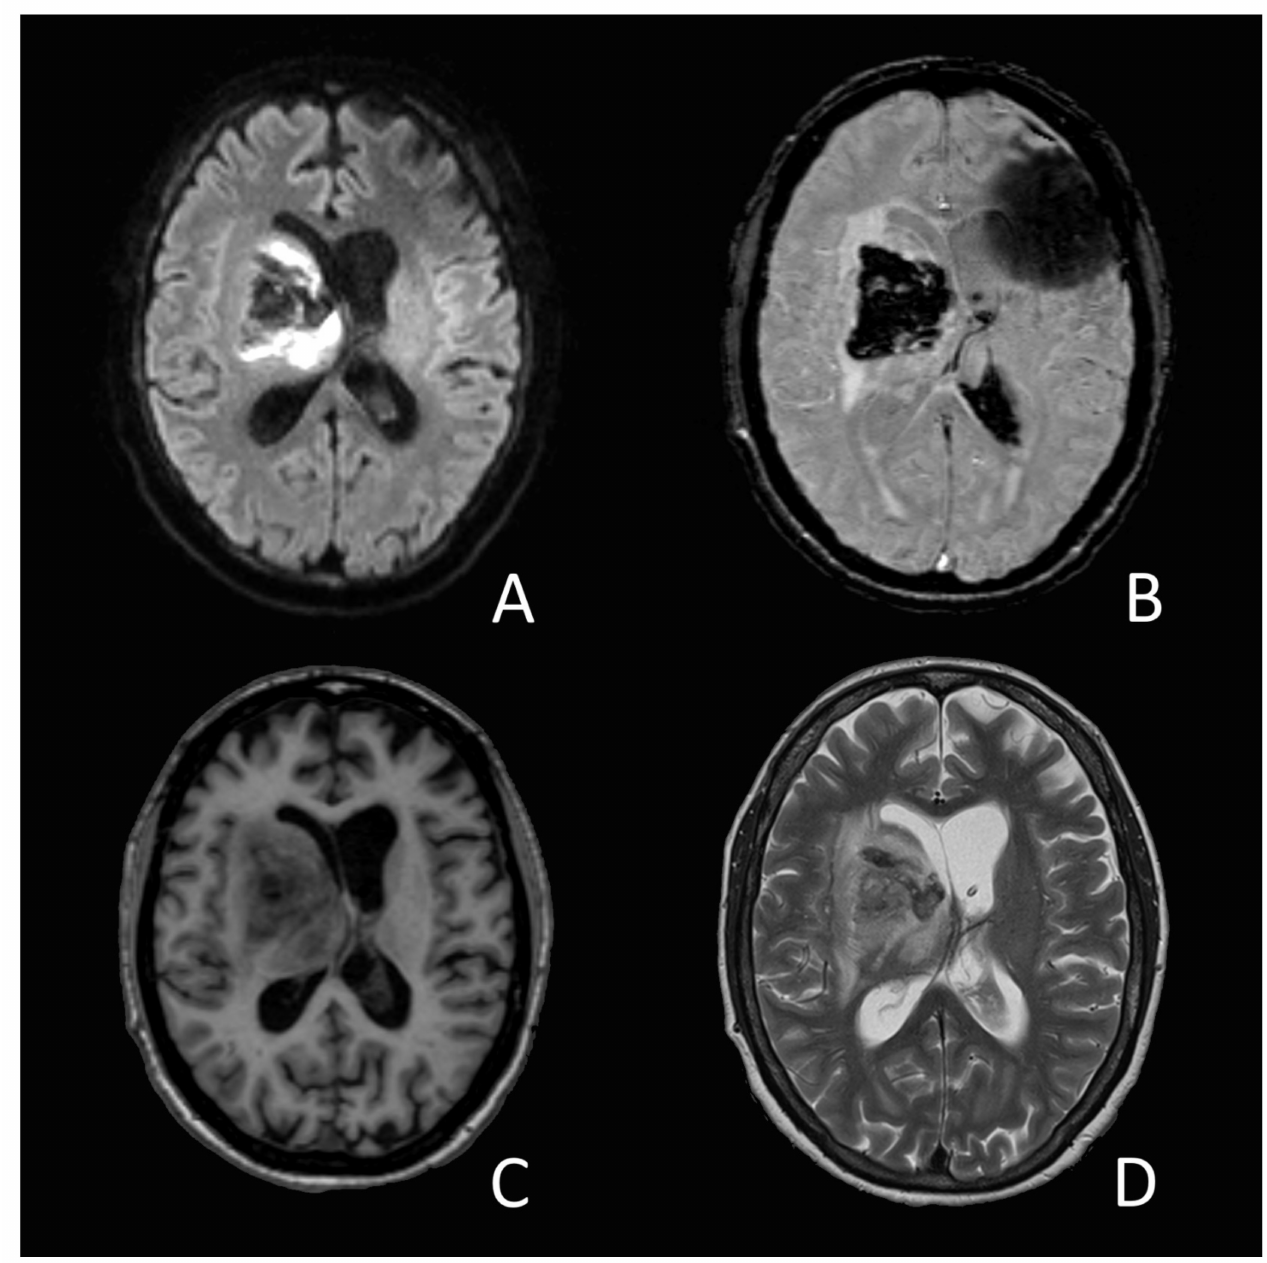
Figure 1. Cranial MRI one day after ICH diagnosis. ( A ) Diffusion weighted imaging (DWI) with b = 1000 s/mm 2 ; ( B ) Susceptibility weighted imaging (SWI); ( C ) T1-weighted MRI; ( D ) T2-weighted MRI. Partially diffusion-restricted, T2-inhomogenous, T1-iso-/-hyperintense intracerebral hemorrhage within the right basal ganglia with subsequent midline shift and compression of the right lateral ventricle and of the third ventricle ( not included in the pictures ). The susceptibility artifact in picture ( B ) (left side, fronto-temporal) is related to the EVD-implantation. In the same picture, a significant blood collection can be seen in the occipital horn of the left lateral ventricle. Microbleeds could not be